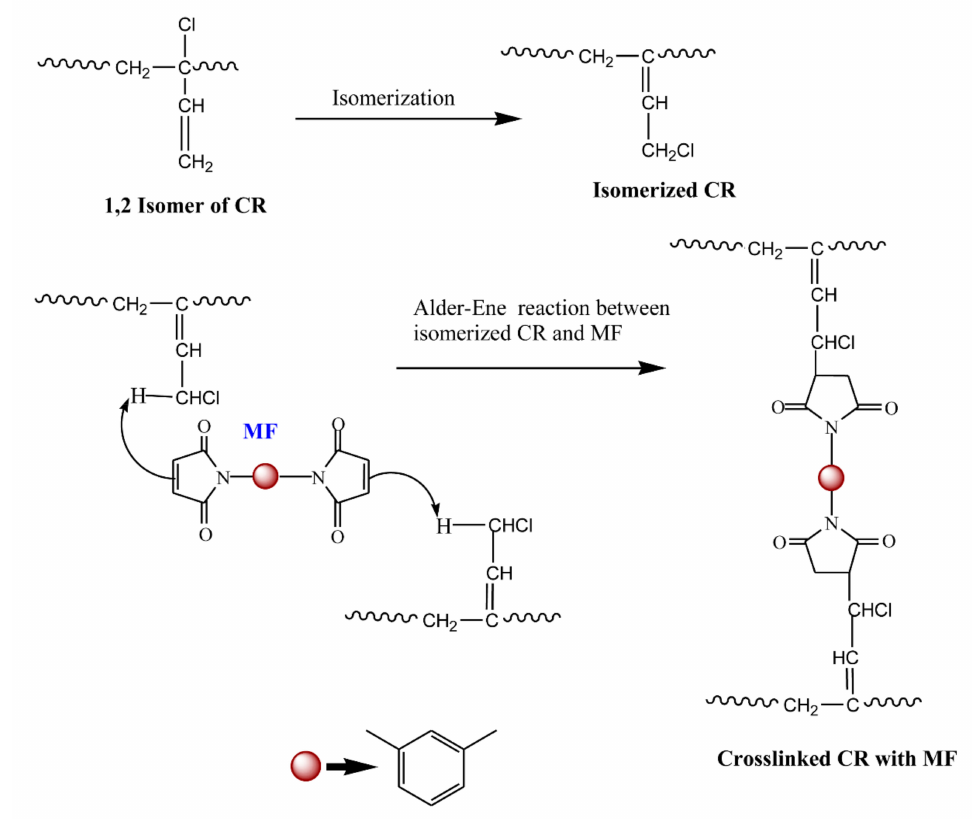
Figure 3. Plausible reaction mechanism for the curing behavior of CR with